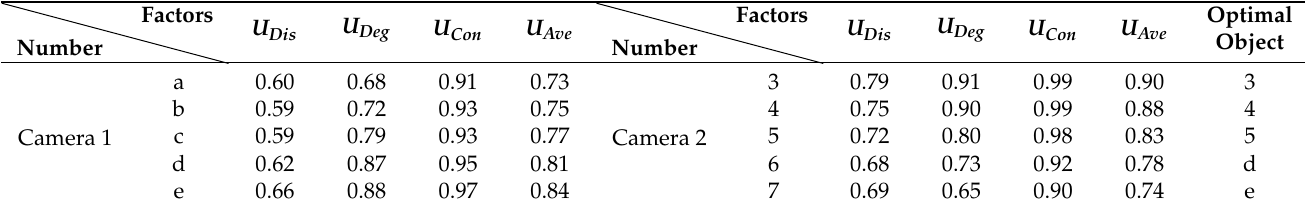
Table 2. The OS-CDD algorithm for an overlapping field in the office.